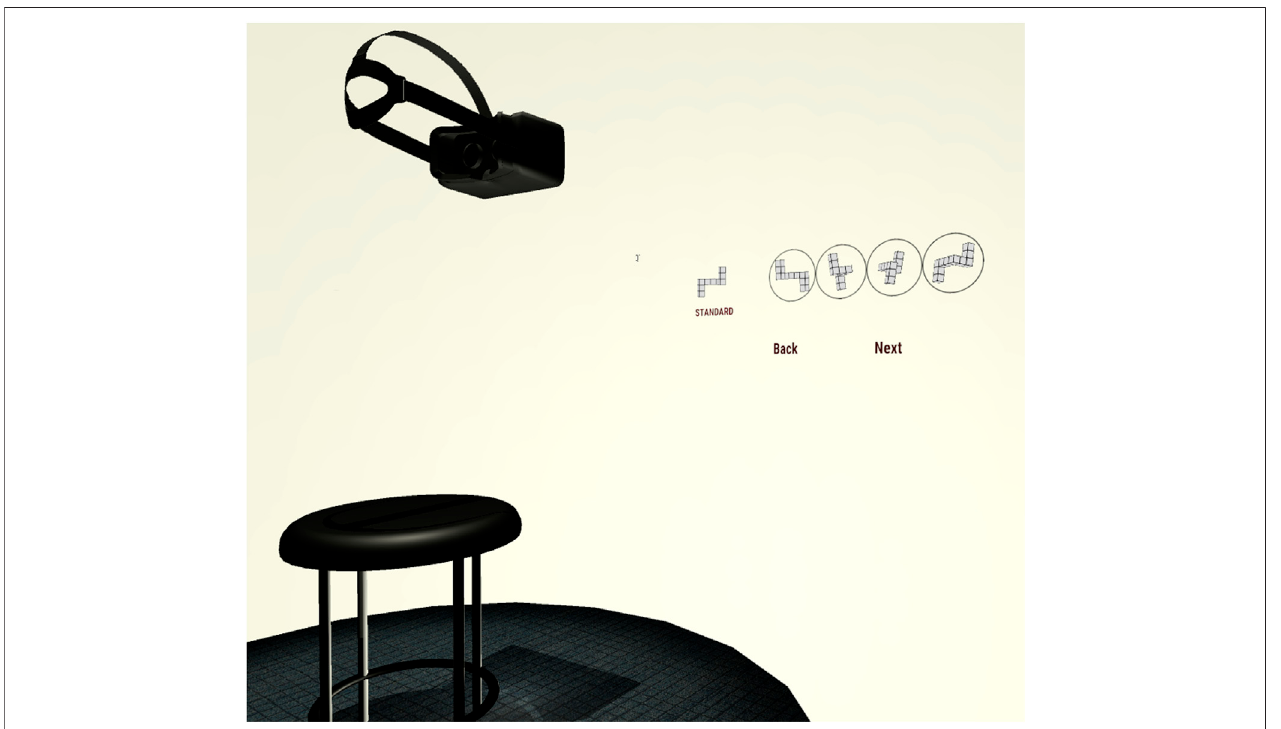
FIGURE3| Athird-personperspectiveofanIMRTparticipant(illustratedbytheHMD)seatedatthecentreoftheVEwiththeteststimuliappearingdirectlyinfrontof them.